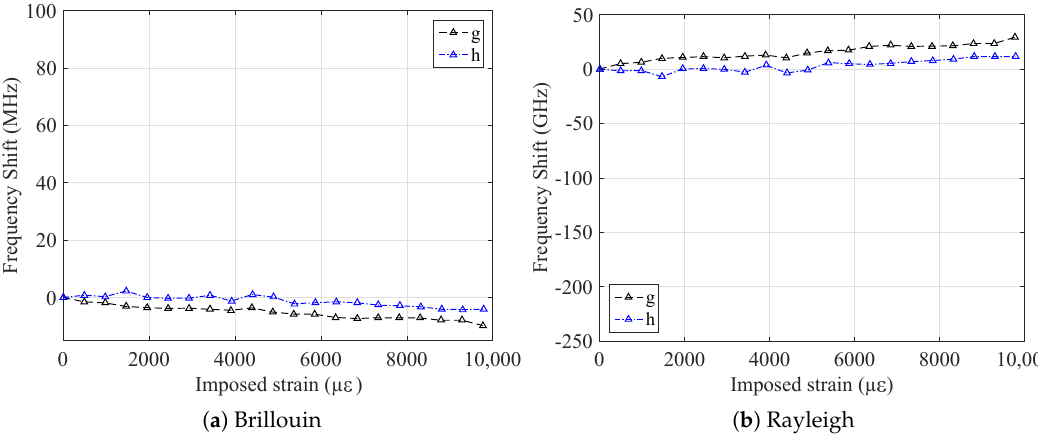
Figure 9. Residual frequency shift of the samples after elongation (represented in the x axis) of the fiber samples for the two tested types of conditions (standard fiber, custom radiation hard fiber).